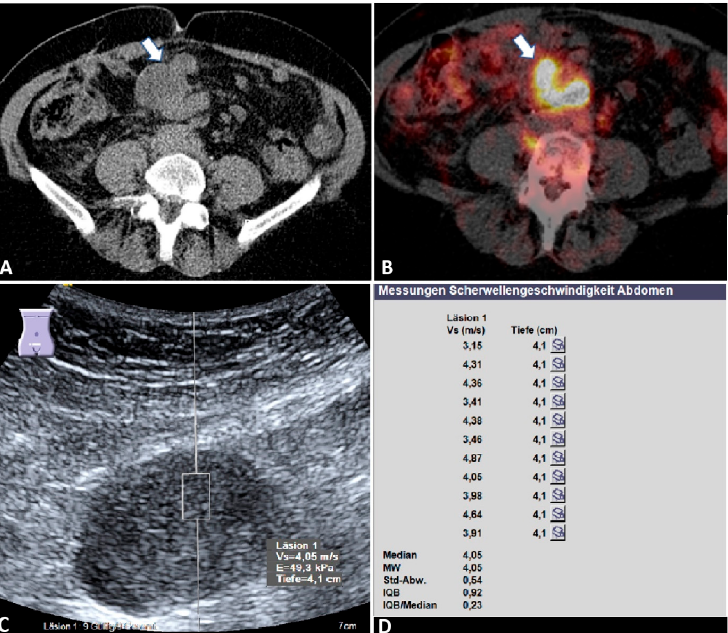
Figure 3. Malignant mesenteric mass. A 76-year-old female patient with a known history of ovarian cancer and suspected recurrence on staging. ( A ) Computed tomography image (left) shows a hypointense mesenteric mass (arrow) (courtesy of Prof. Dr. Mahnken, Department of Radiology,